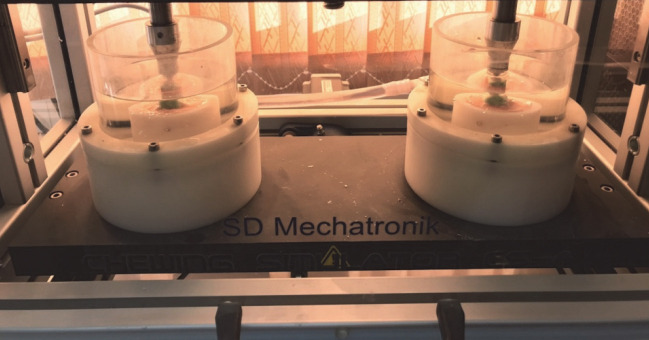
 Studied specimens in chewing simulator machine